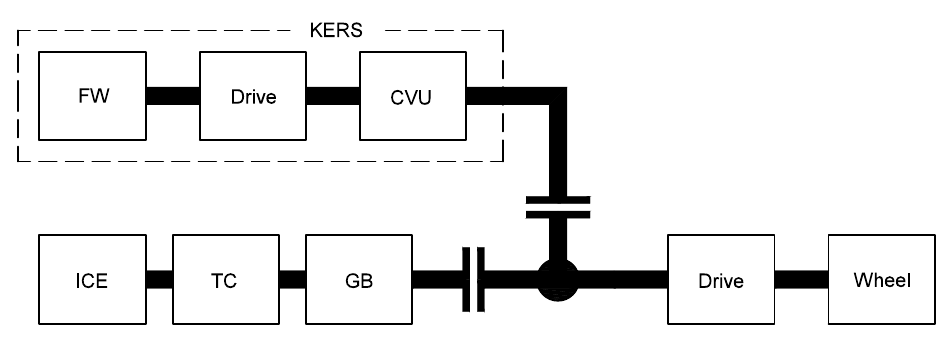
Figure 5. Schematic picture of the mechanical hybrid (HM)